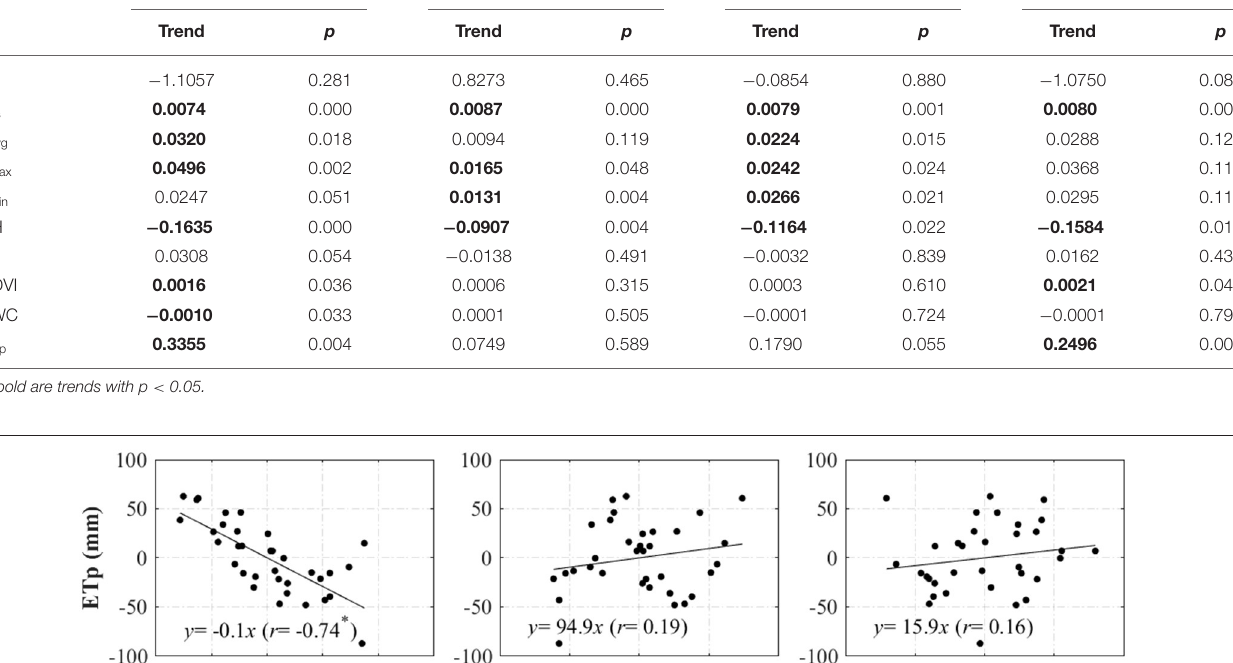
the sequence of R s , P, RH, T max , NDVI, SWC, and T avg with a correlation coefficient of 0.94, 0.48, 0.47, and 0.40, respectively. To sum up, −